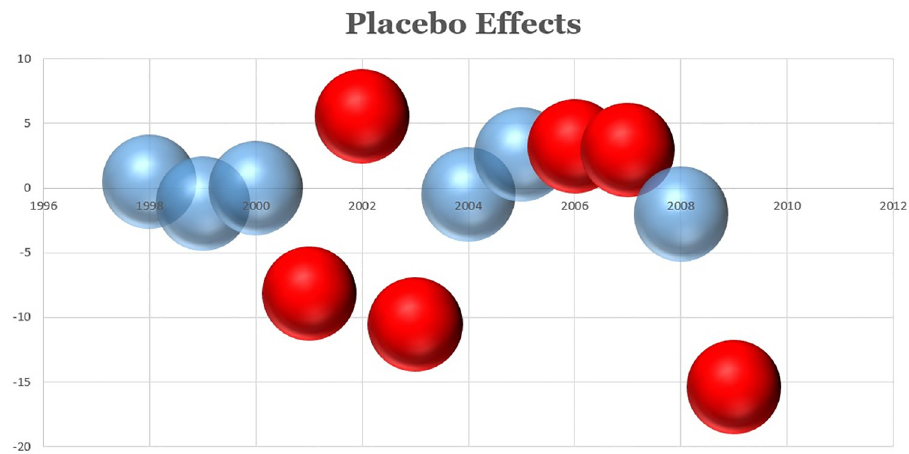
Fig 6. Placebo test for the DID estimation to measure the effect of the LCFS on emissions.